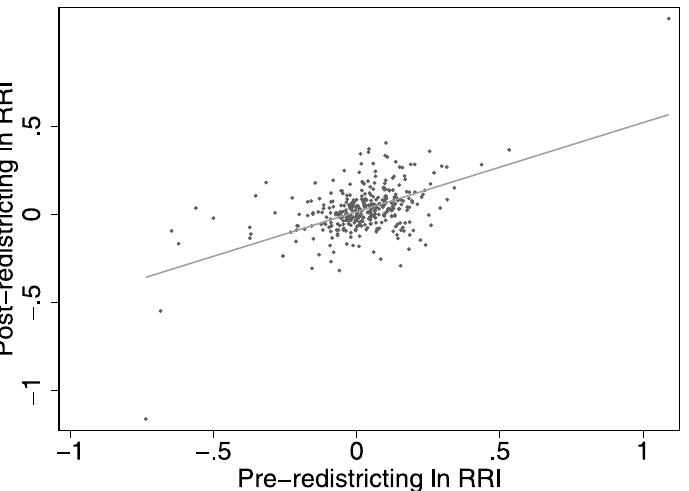
Fig 1. The relative representation index across India’s districts before and after redistricting. The line of best fit has slope 0.4.